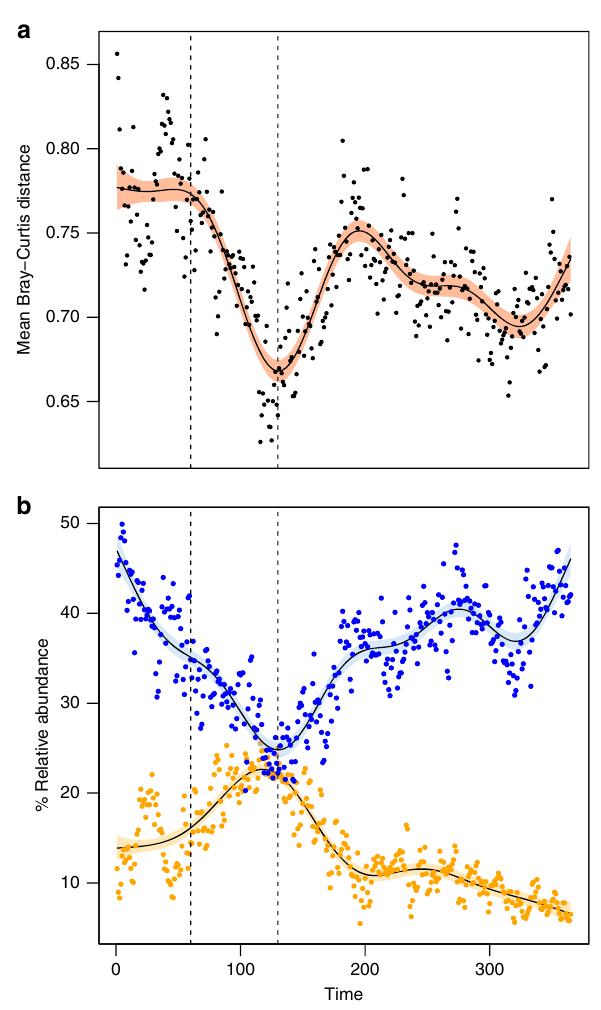
Fig. 2 The infant GI microbiota goes through a period of accelerated convergence approximately between days 60 and 130 after birth. All data series were interpolated to equal length (365 pseudo-days) for this analysis. Dots show the observed values while lines show fi tted generalized additive models ( p ≪ 0.001 for all model fi ts). a Mean pairwise contemporaneous Bray – Curtis distances between 11 infants* ( R 2 = 0.65). b Relative abundances of Bi fi dobacterium longum/breve (OTU1) (yellow, R 2 = 0.79) and Firmicutes (blue, R 2 = 0.74). Shaded bands represent 95% con fi dence limits for the fi tted models. Dotted vertical lines indicate the window of convergence (days 60 – 130). * ID8 was excluded from this analysis since sampling did not commence until day